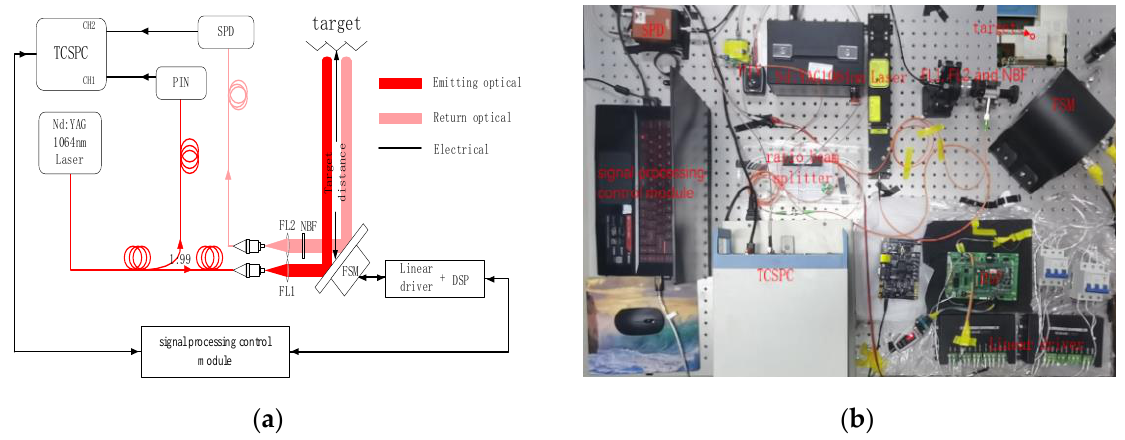
Figure 1. ( a ) Block diagram of APTR system based on single photon detection; ( b ) the experimental platform of APTR system based on single photon detection.